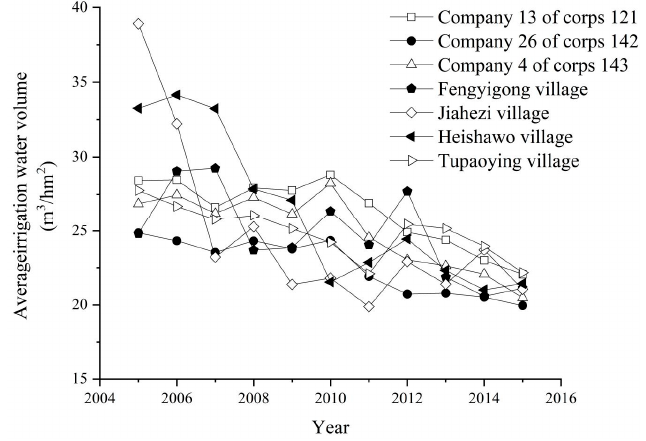
Figure 7. Analysis of irrigation water consumption in the seven sampled villages, 2005–2015.